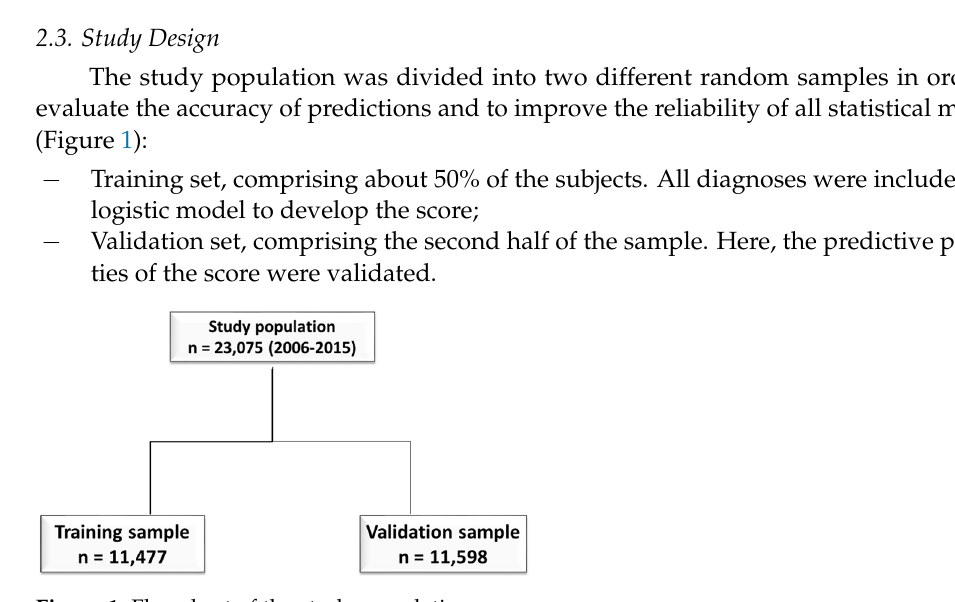
Figure 1. Flowchart of the study population.